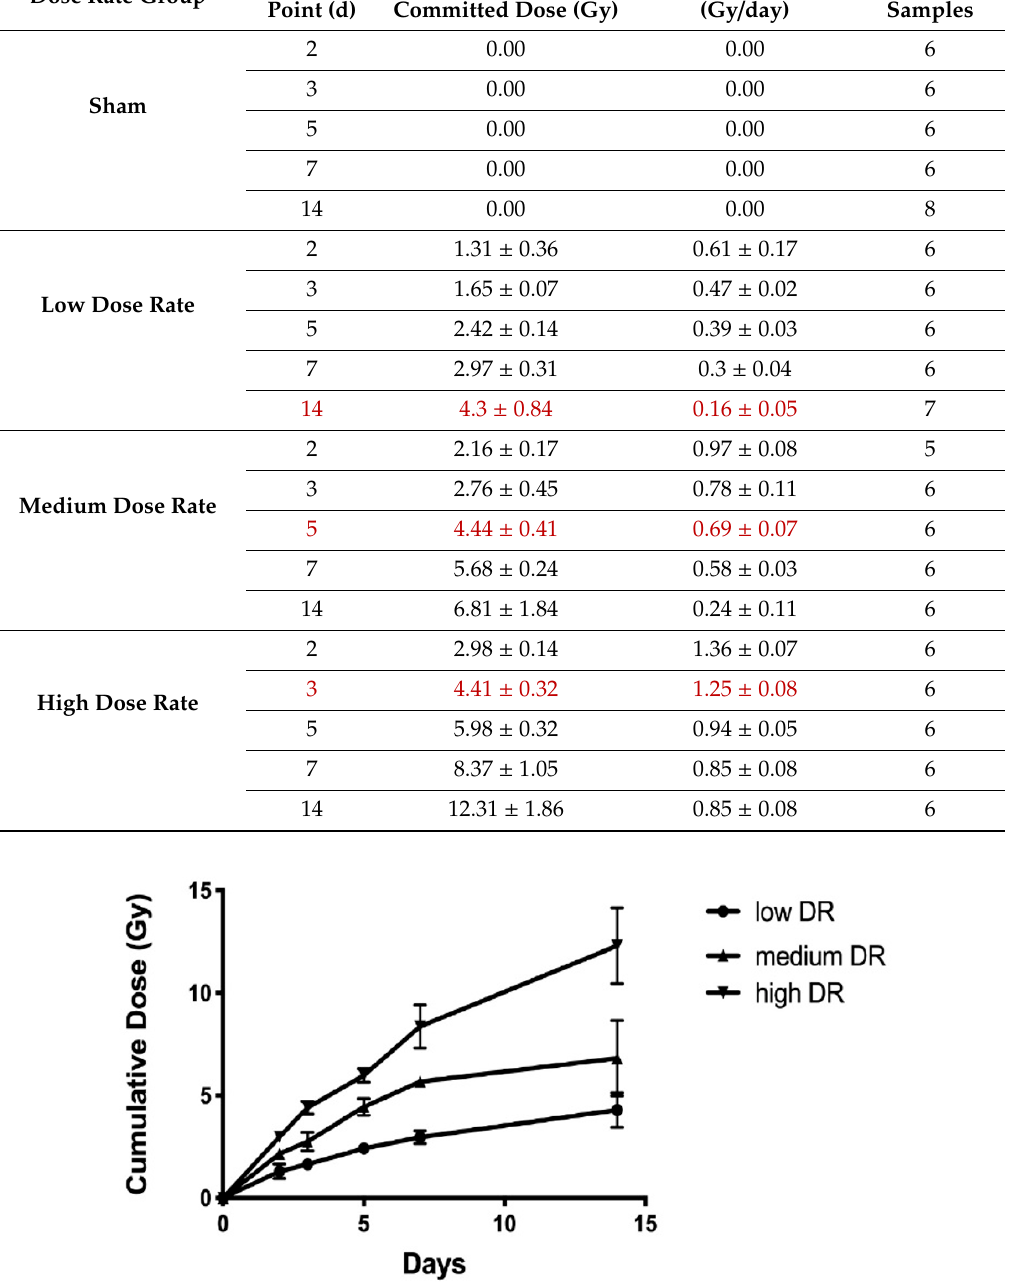
Table 1. Total-body dose (Gy) and dose rates (Gy/day) measured over the 14-day study period. The dose and the corresponding dose rates on the day when the accrued dose reached 4 Gy are marked in red for each group.